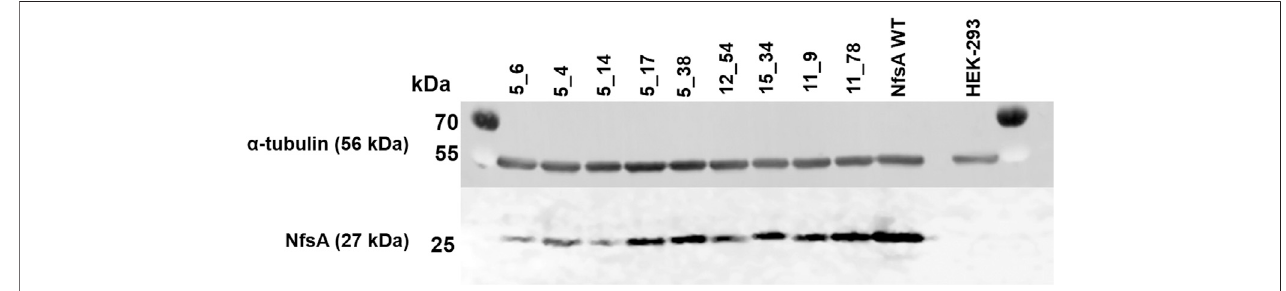
FIGURE 3 | Western blot depicting expression of NfsA and variants by stably-transfected HEK-293 cell lines. HEK-293 cells were lysed with RIPA buffer and probed for NfsA expression by immunoblot using an NfsA polyclonal primary antibody and an anti-IgG HRP conjugate secondary antibody. The expression level of α -tubulin in samples was additionally determined via immuno fl uorescence detection and served as a loading control.